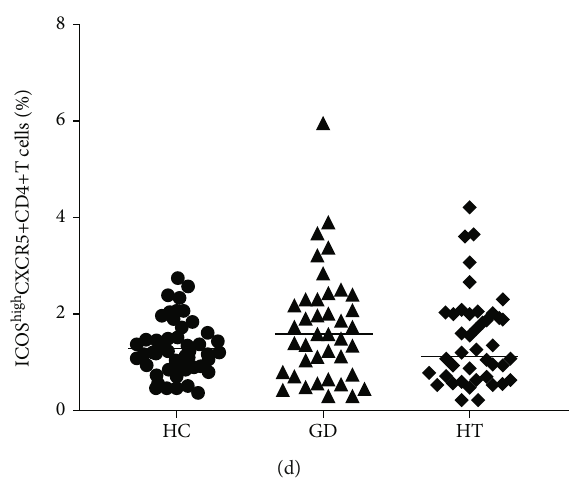
Figure 1: The frequencies of CD4 + CXCR5 + , CD4 + CXCR5 + PD-1 + , and CD4 + CXCR5 + ICOS high Tfh cells in the peripheral blood of GD and HT patients. (a) Representative dot plot showing the gating strategy for Tfh cells gated on CD4 + T cells. (b – d) The frequencies of CD4 + CXCR5 + , CD4 + CXCR5 + PD-1 + , and CD4 + CXCR5 + ICOS high Tfh cells in patients with GD ( n = 40 ), HT ( n = 40 ), and healthy controls ( n = 40